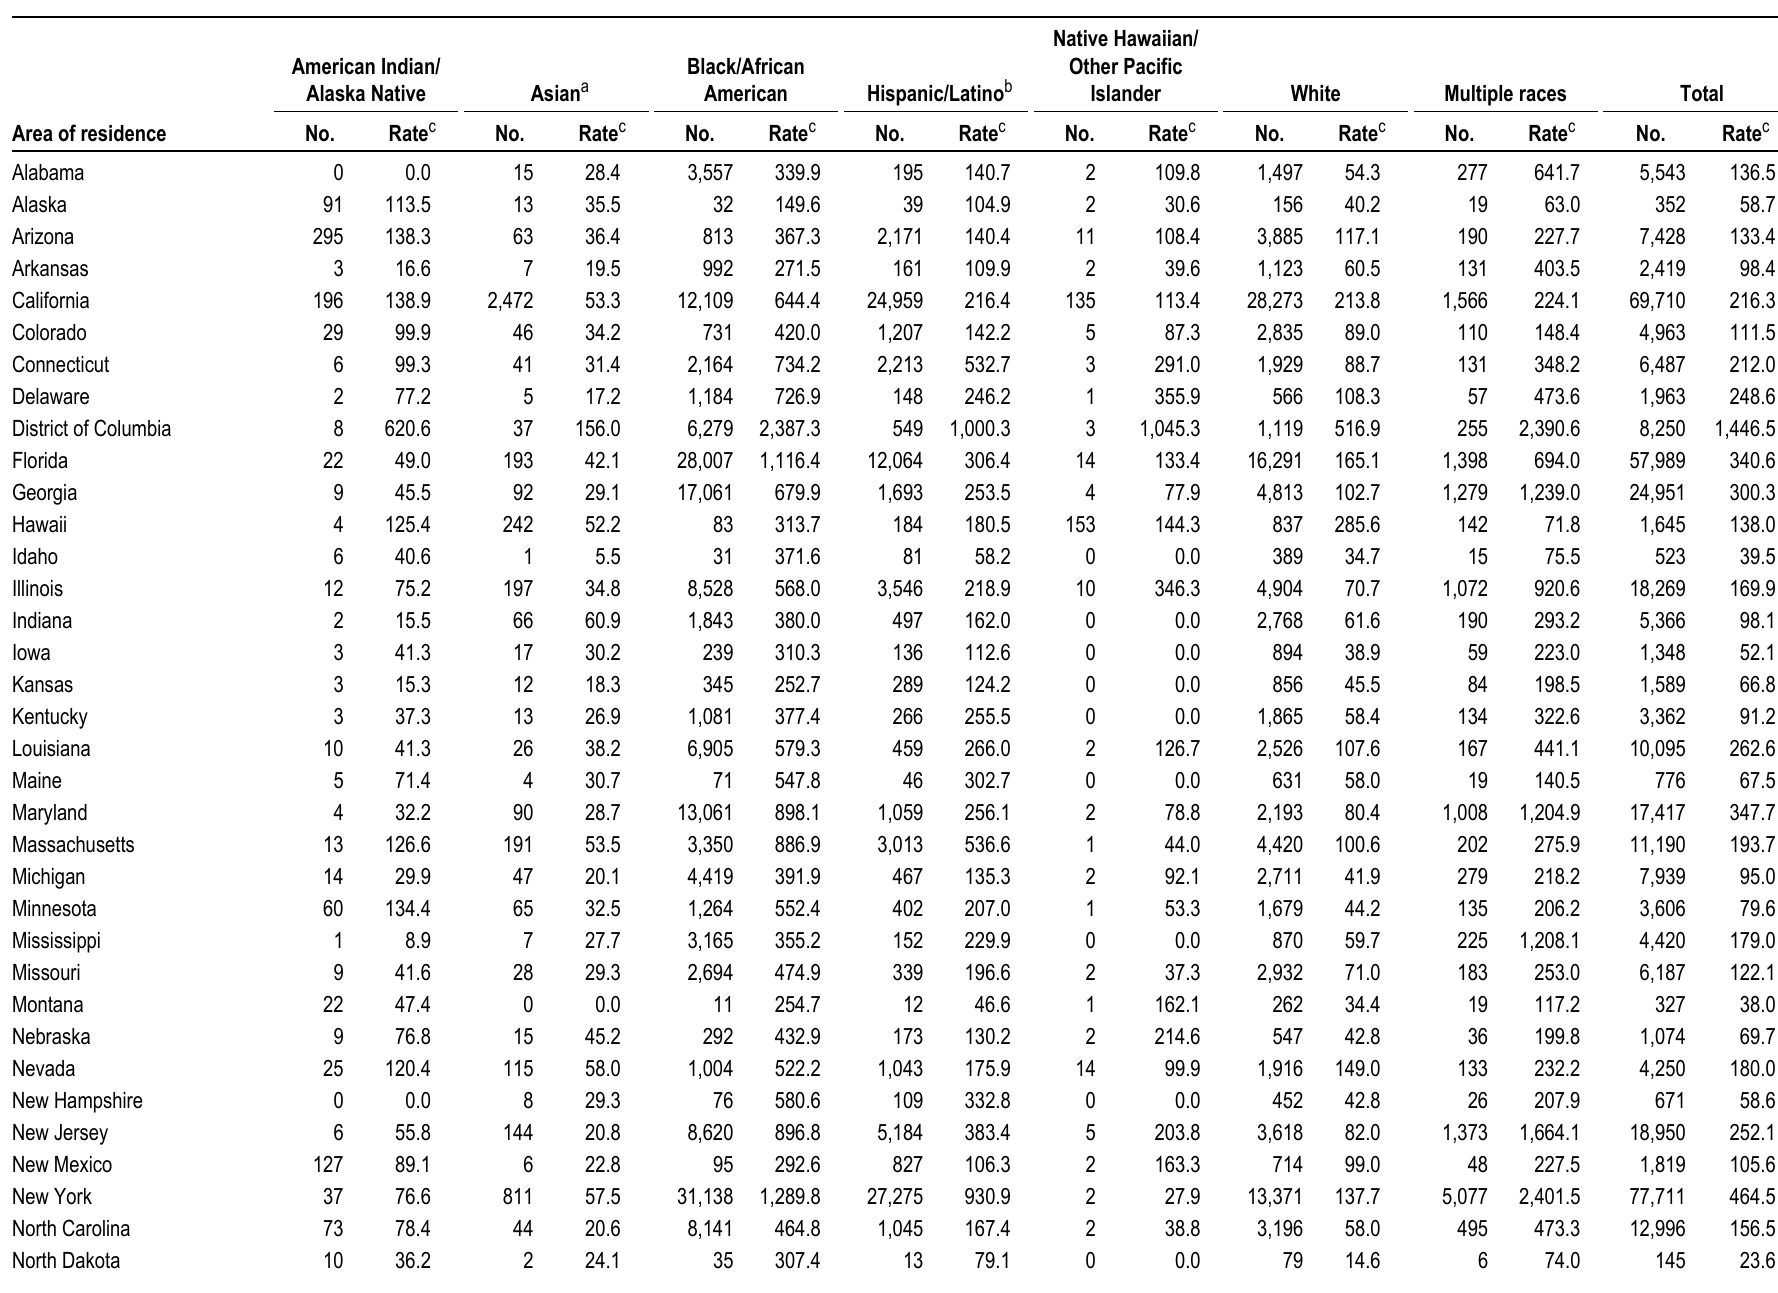
Table 25. Adults and adolescents living with diagnosed HIV infection ever classified as stage 3 (AIDS), by race/ethnicity and area of residence, year-end 2014—United States and 6 dependent areas Native Hawaiian/ American Indian/ Black/African Other Pacific Alaska Native Asian a American Hispanic/Latino b Islander White Multiple